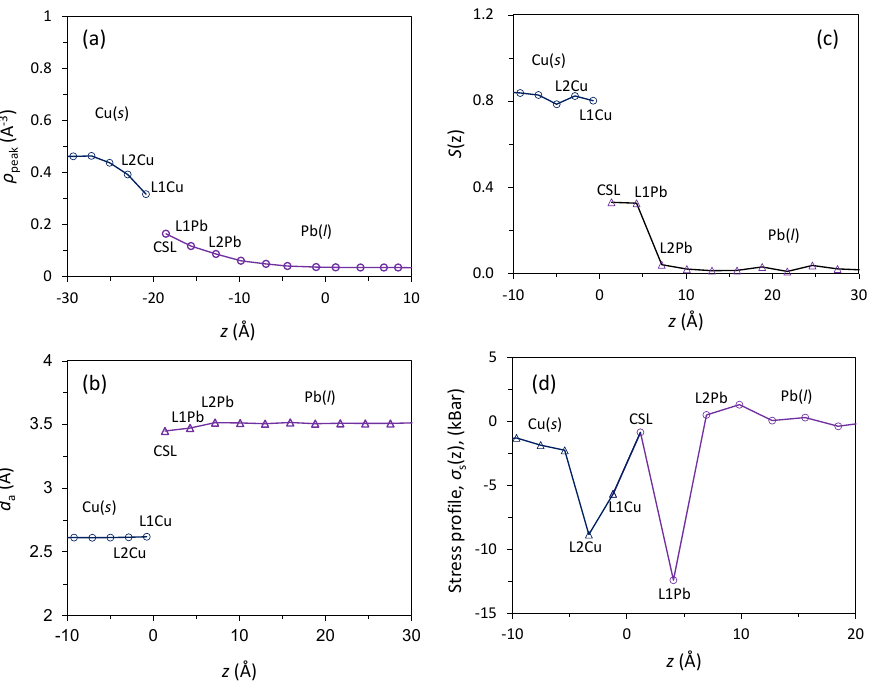
Figure 3. Characteristics of the 2D ordered structures in liquid Pb adjacent to the Pb( l )/Cu( s ) interface equilibrated at 625 K; ( a ) peak density, ρ p ( z ); ( b ) in-plane order parameter, S ( z ); ( c ) average in-plane atomic spacing, d a ; and ( d ) local stress distribution, σ s ( z ), are plotted as a function of the distance, z , from the